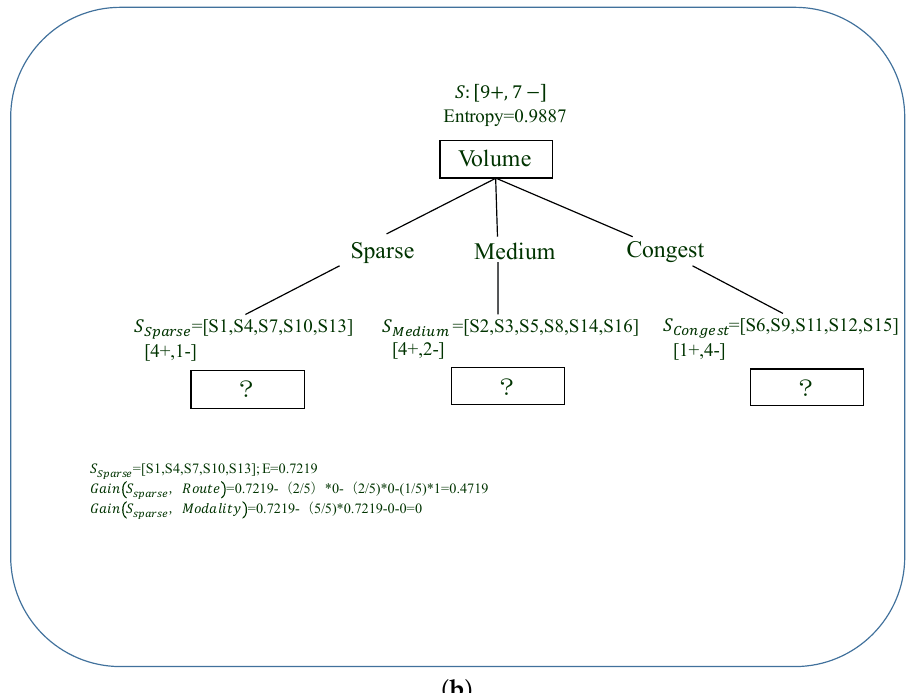
Figure 2. ID3 is used to build the incentive decision tree according to the sample data for group S (Step 1).